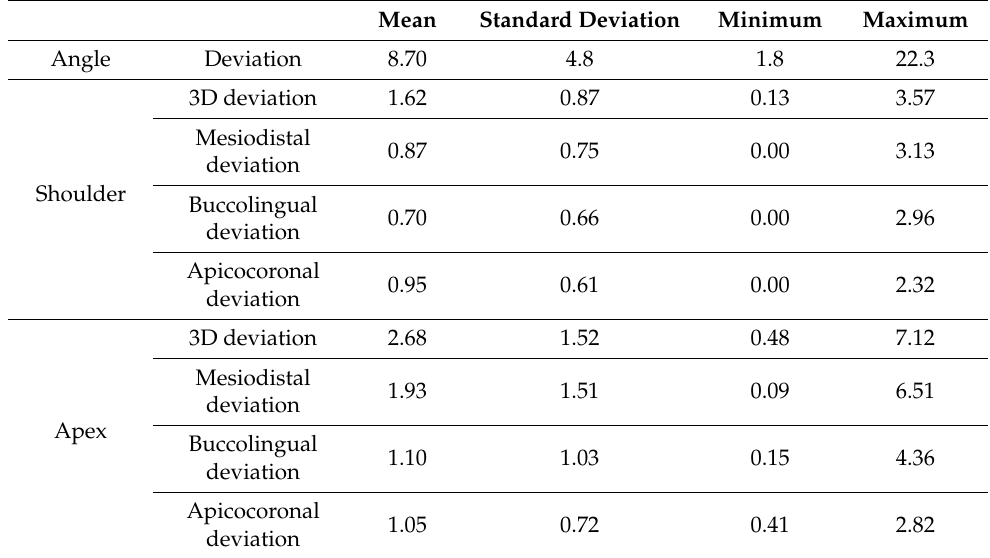
Table 3. Angular deviation ( ◦ ) and deviations at the shoulder and at the apex (mm) in the total group with 52